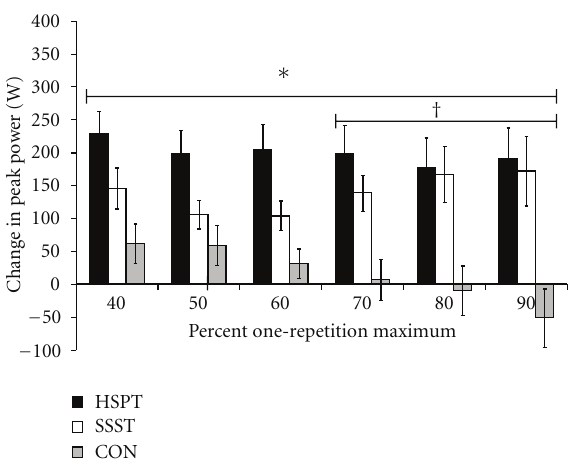
Figure 3: Baseline to posttraining changes in leg press peak power relative to baseline one-repetition maximum (1RM) across a range of external resistances. HSPT = high-speed power training; SSST = slow-speed strength training; CON = control. ∗ HSPT > CON; † SSST > CON.